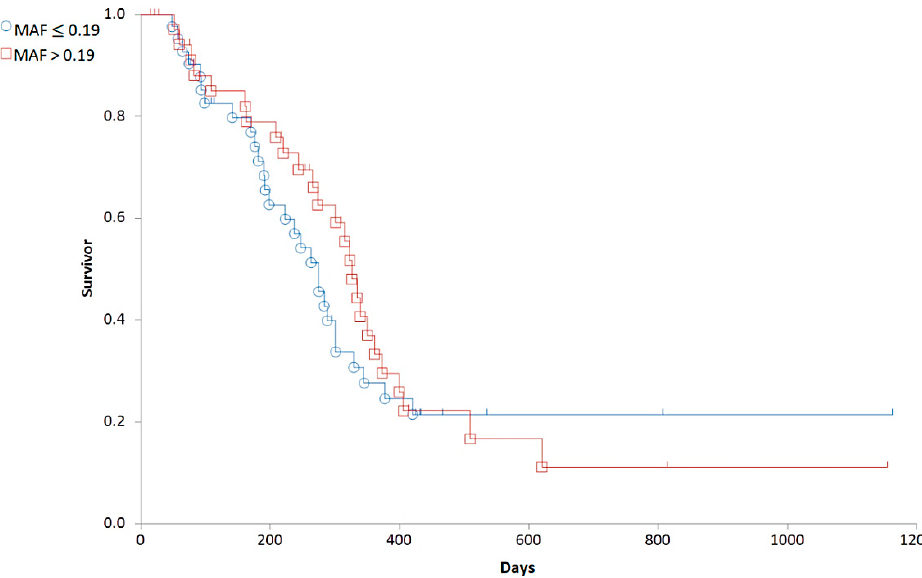
Figure 6. Relapse free survival of canine lymphoma patients with MAF ≤ 0.19 (blue circle) and MAF > 0.19 (red squares).